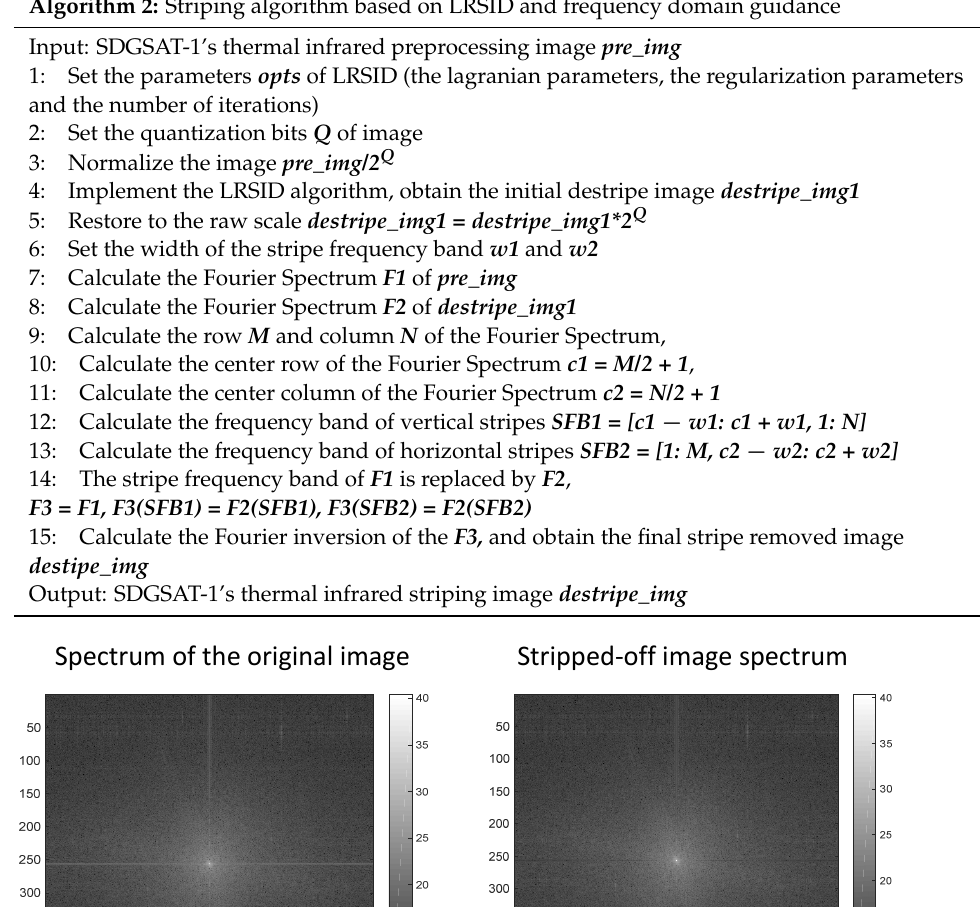
5 of 14 Algorithm 2: Striping algorithm based on LRSID and frequency domain guidance Input: SDGSAT ‐ 1’s thermal infrared preprocessing image pre_img 1: